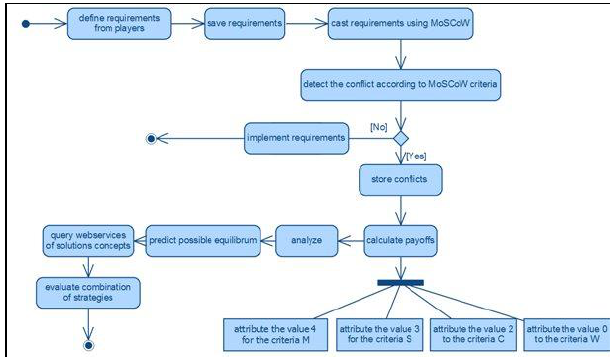
Figure 4. The activity diagram of the automatic analysis process